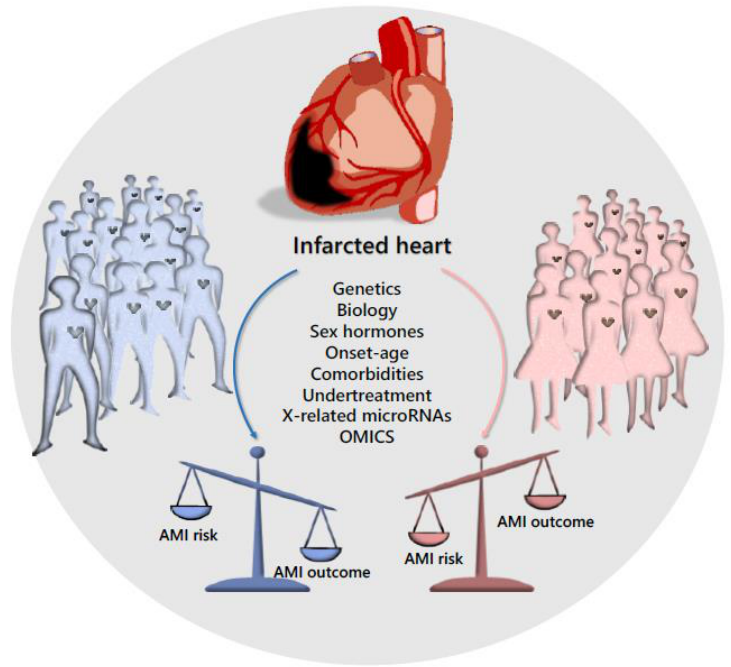
Figure 2. Extreme clinical phenotypes and prognosis in male and female AMI patients. The increased AMI risk in males is balanced by a better prognosis, resulting in enhanced AMI outcome. Conversely, the reduced AMI risk in females is characterized by a worst prognosis, resulting in a poor AMI outcome.